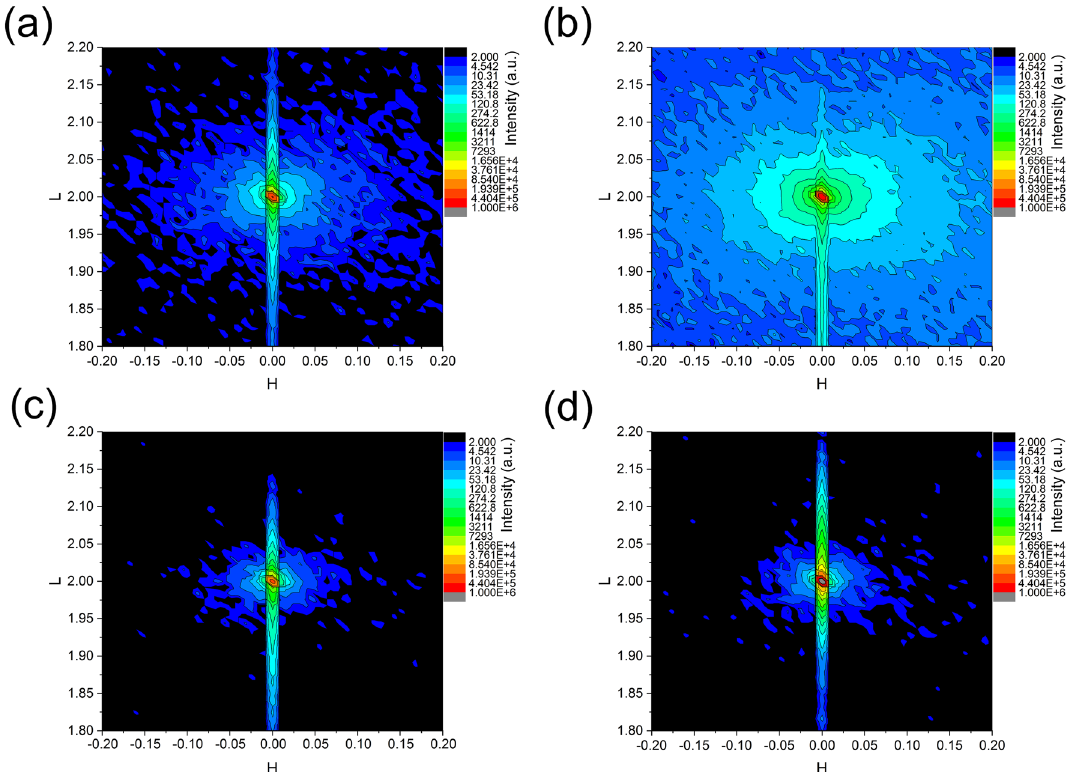
Figure 2. RSMs (reciprocal space mapping) near symmetric 002 reflection of (001)-oriented SrTiO 3 single crystals. ( a ) RSM of undoped SrTiO 3 single crystal; ( b ) RSM of 0.5% Nb doped SrTiO 3 single crystal; ( c,d ) RSMs of undoped and 0.5% Nb doped SrTiO 3 single crystal which was annealed in a tube furnace in air at the temperature 930 °C for 2